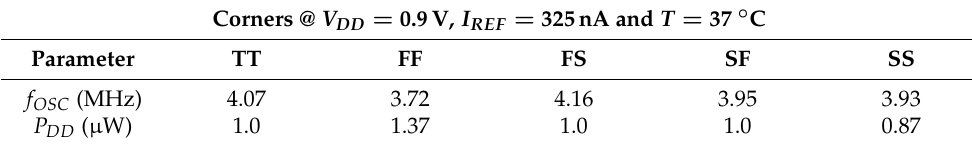
Table 2. Corner simulations of CSGRO at body temperature (37 ◦ C).